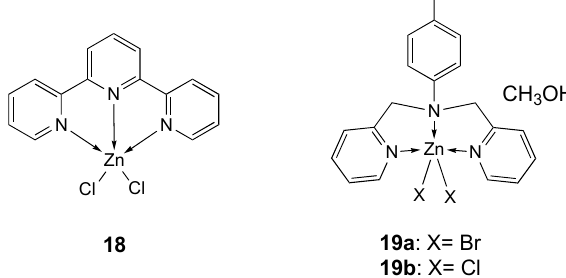
Figure 10. Structure of the zinc complexes 18 and 19a , 19b .